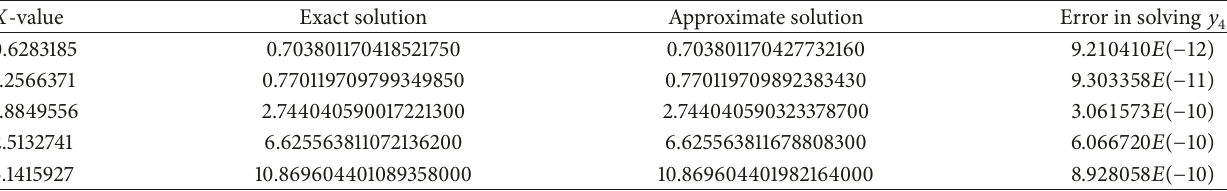
Table 12: Exact and approximate solutions for solving 𝑦 4 using the developed method. 𝑋